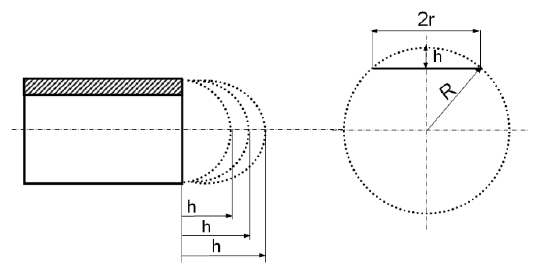
Figure 2. Scheme presenting the determination of the radius of curvature. R is radius of curvature, r is radius of the Teflon cap, h is the convexity of the bilayer. The radius of curvature was calculated as R = r 2 + h 2 / 2 h .